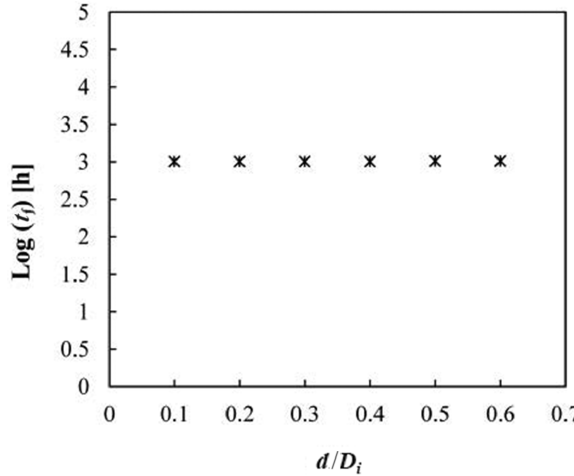
Figure 12: The effect of the TBS depth, d , on the failure